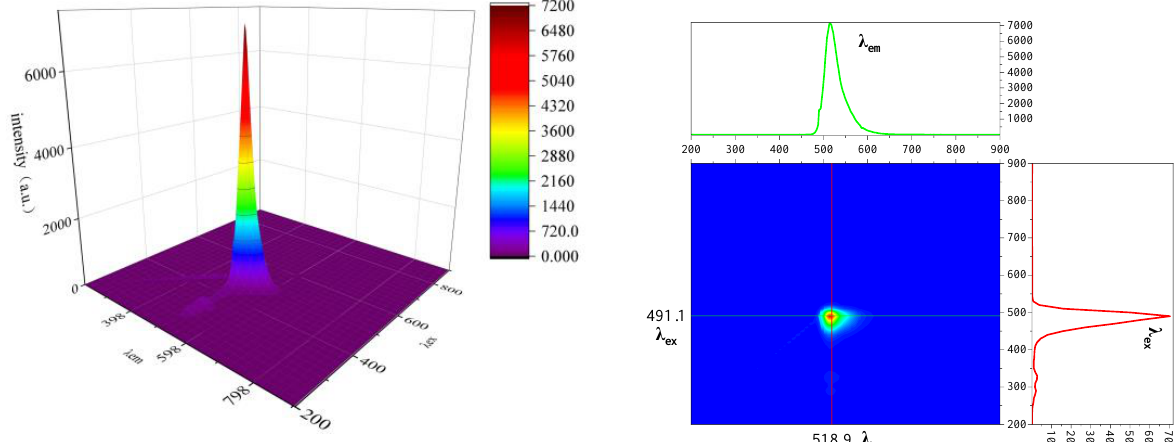
Figure 6. 3D scanning situation of CQD-W ( left ) top view profile of CQD-W ( right ).